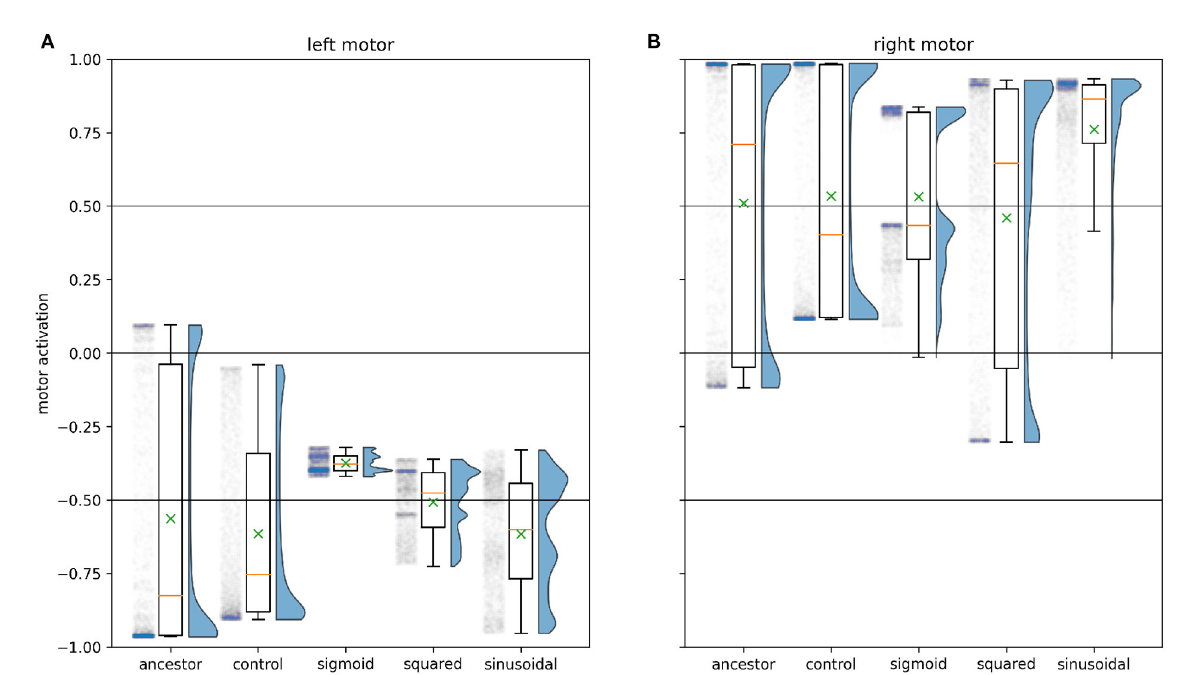
FIGURE6 Motor activity for the 12 light positions shown in Figure 3 for time 20 to time 50 (integration steps 2,000–5,000), for the evolved solution to each experiment. This is one way of visualizing aspects of the ancestral behavior that have (and have not) been modified by further evolution in the presence of an interference function. The boxes extend from the first to the third quartile of the motor activity, and contain a yellow line showing the median, and a green showing the mean. The whiskers extend to 1.5 times the inter-quartile range. The half-violin plot to the right × of each box plot estimates the distribution of the motor activity, while to the left is a scatter plot of each simulated moment of motor activity with randomized horizontal placement. The column labeled control plots exactly the same information for the fittest solution evolved with λ 0.5 and the null interference function ψ ( m ) 0, showing the scope of change seen simply due to the presence of λ and to genetic drift. (A) = = plots the motor activity for the left motor of each system, while (B) plots this information for the right motor. Of particular relevance to the solutions cataloged in this paper are the depressed (absolute) left motor activation with sigmoidal interference and the corresponding bimodal distribution of right motor activity; the reduced range of left motor activity with squared interference, and the fact that the right motor activation with squared interference continues to cover a wide range; and the reduction in low (absolute) values of motor activity with the sinusoidal interference